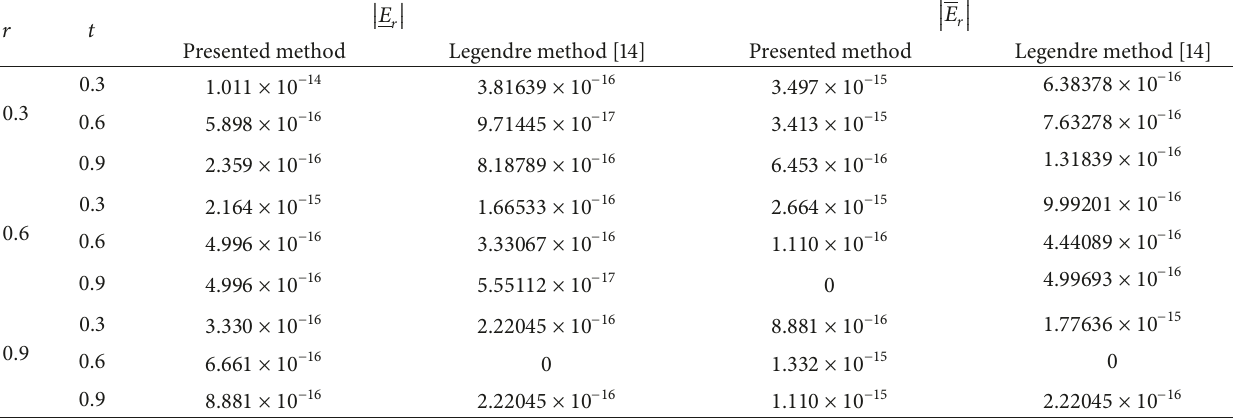
Table 1: Comparing the absolute errors of the presented method and the method of [14] for Example